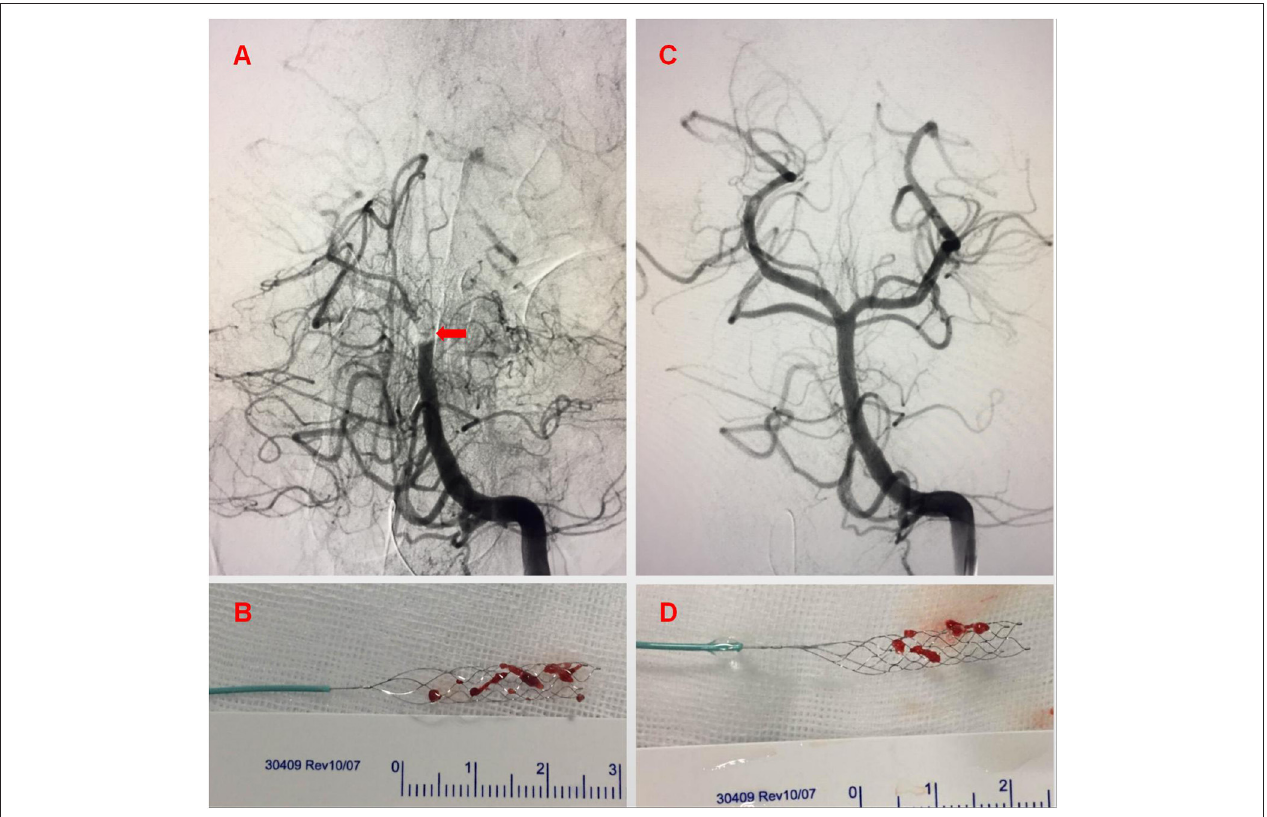
FIGURE 3 | Some residual thrombus remained at the top of the basilar artery (A) after the first retrieval of the thrombus with stent (B) (arrow). After the second retrieval of the thrombus (D) , the basilar artery perfusion recovered completely (C)